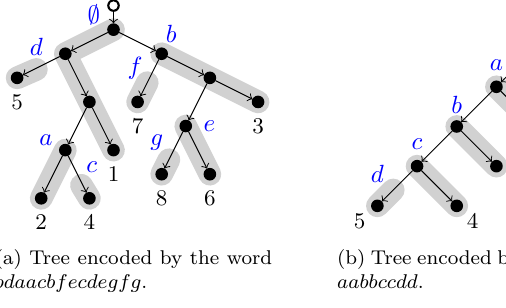
Figure 3. Examples of Tree